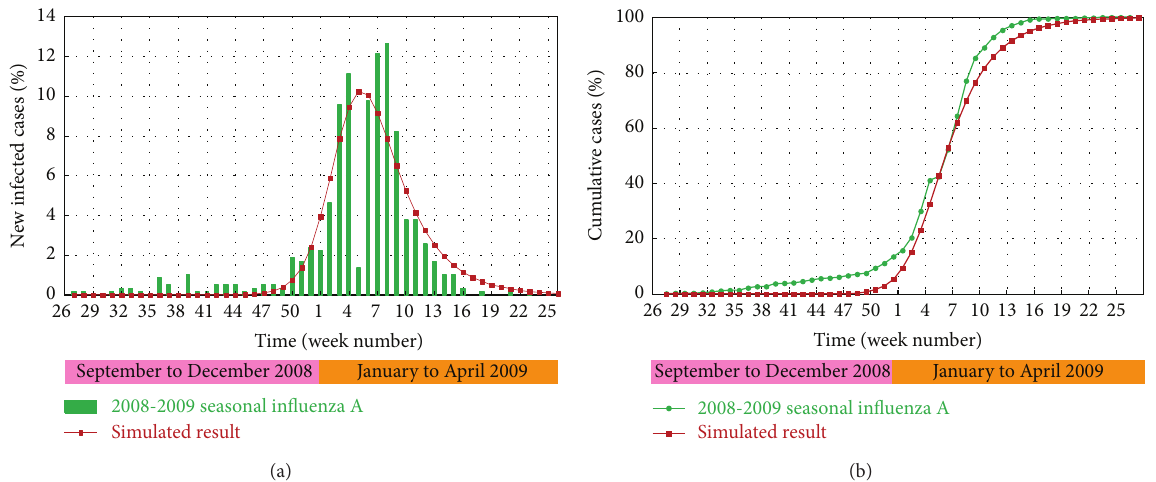
Figure 8: Comparison of actual and simulated results for (a) weekly new infected cases and (b) cumulative cases normalized for 2008-2009 seasonal influenza